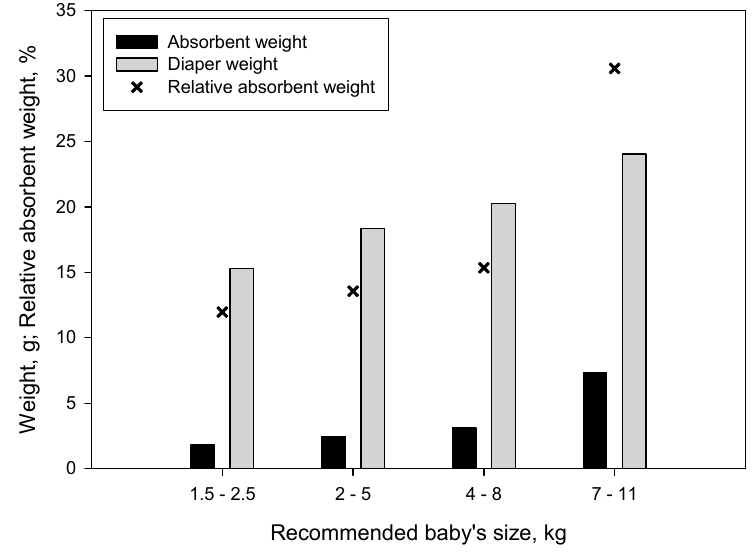
Figure 8. Diaper weight and amount of absorbent as function of the diaper size.